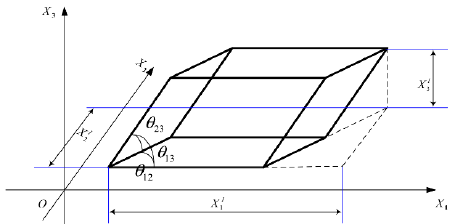
Figure 3. Three-dimensional parallelepiped model.